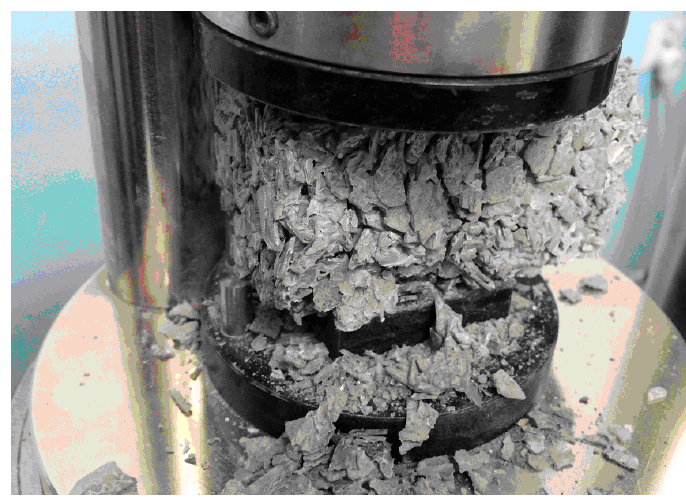
Figure 4. View of the CG-100 concrete sample during the compressive strength test.